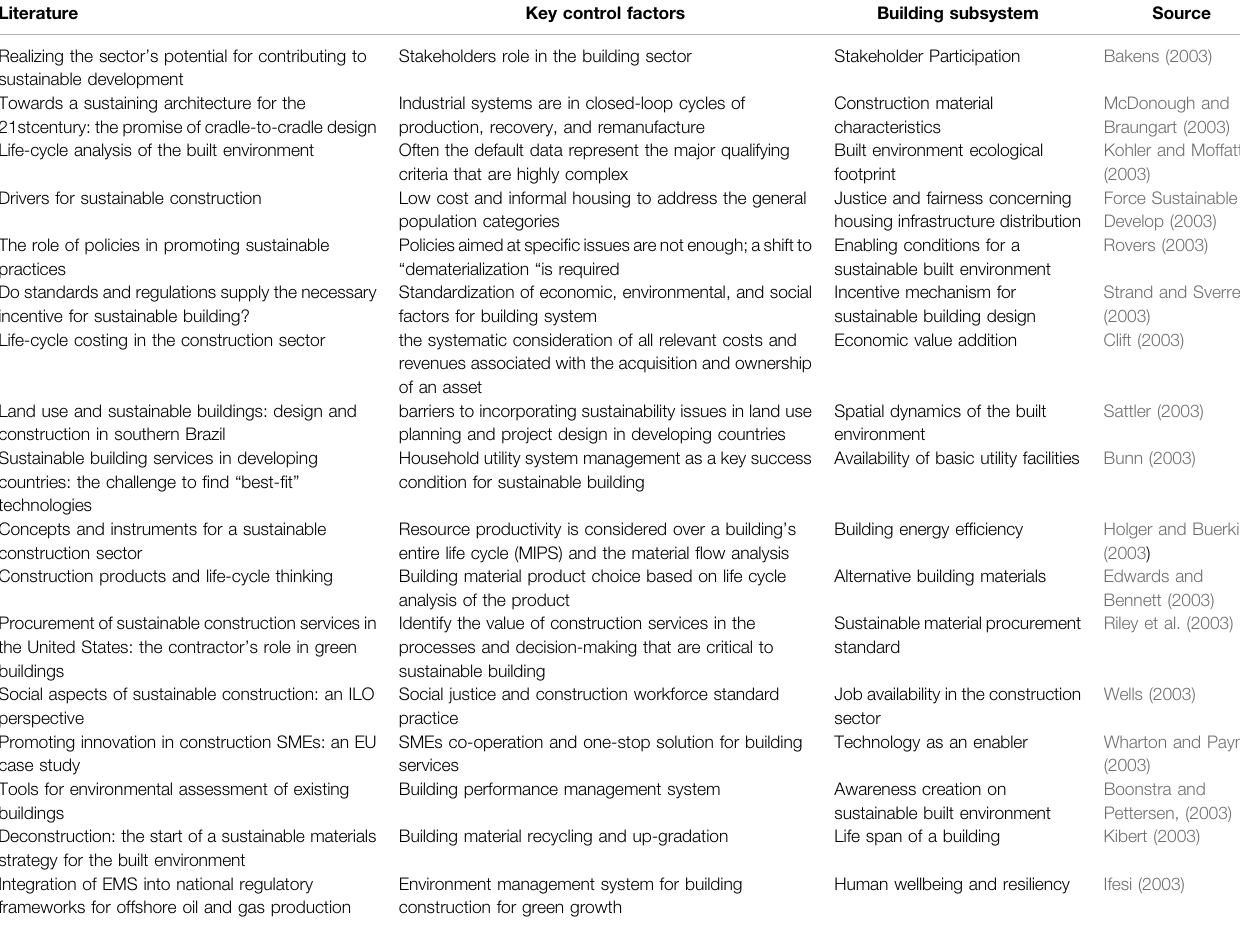
TABLE 1 | Global in fl uence factors of built environment design as a